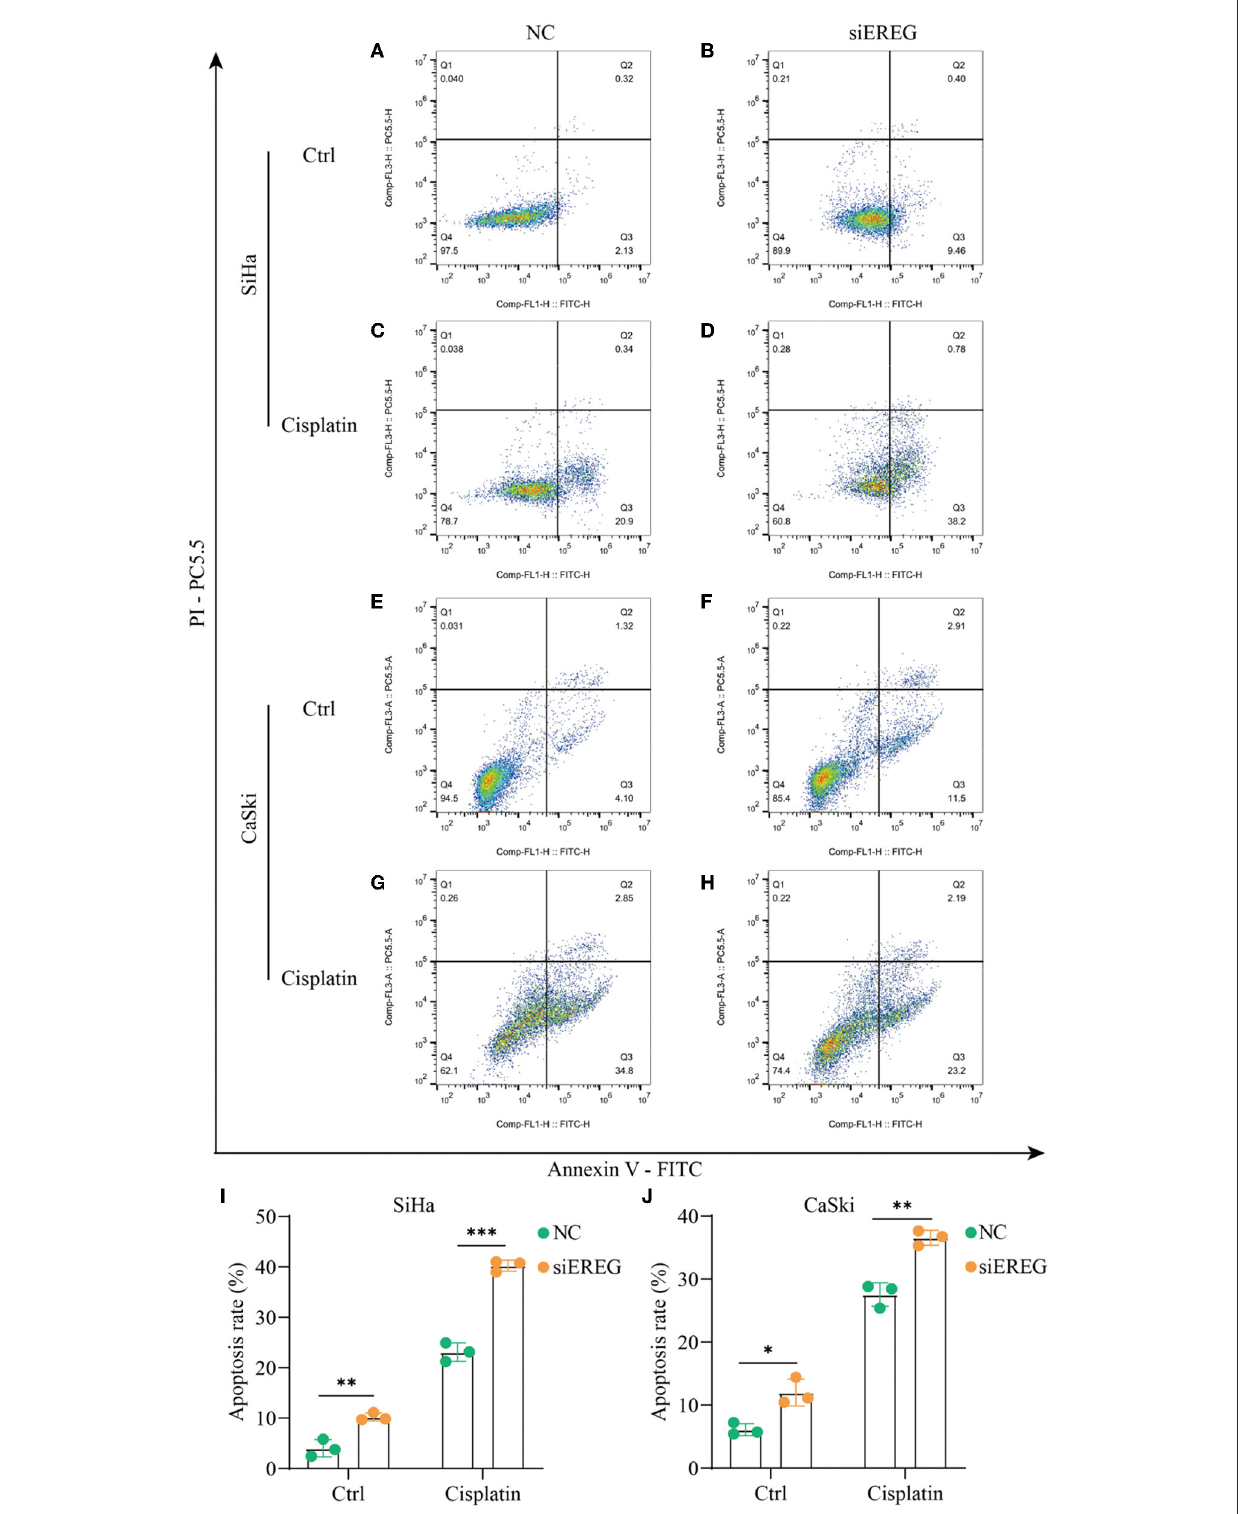
FIGURE8 The changes in apoptosis when EREG was knocked down in cervical cancer cells with or without cisplatin treatment. Flow cytometry showed the apoptosis rate of SiHa cells after siRNA transfection, followed by treatment with 10 µ M cisplatin (C, D) or not (A, B) for 48h. Flow cytometry exhibited the apoptosis rate of CaSki cells after siRNA transfection, followed by treatment with 5 µ M cisplatin (G, H) or not (E, F) for 48h. The histogram showed the apoptosis rate of SiHa (I) and CaSki (J) with different treatments. “*” represents p < 0.05, “**” represents p < 0.01, and “***” represents p <